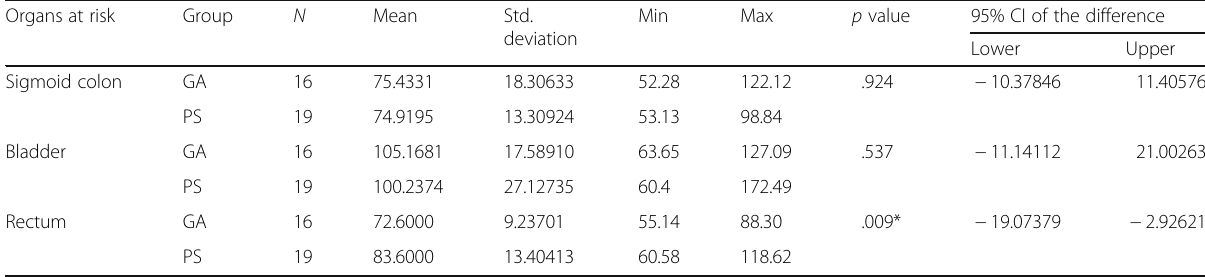
Table 2 EQD2 dose received by 0.1 cc